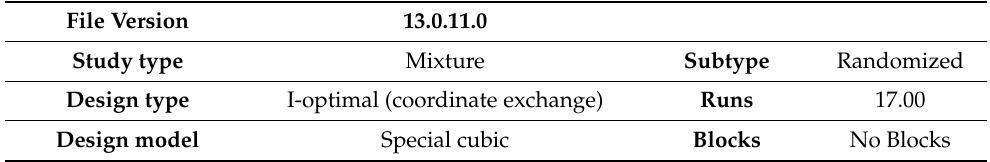
Table 7. The characteristics of the experimental design model.